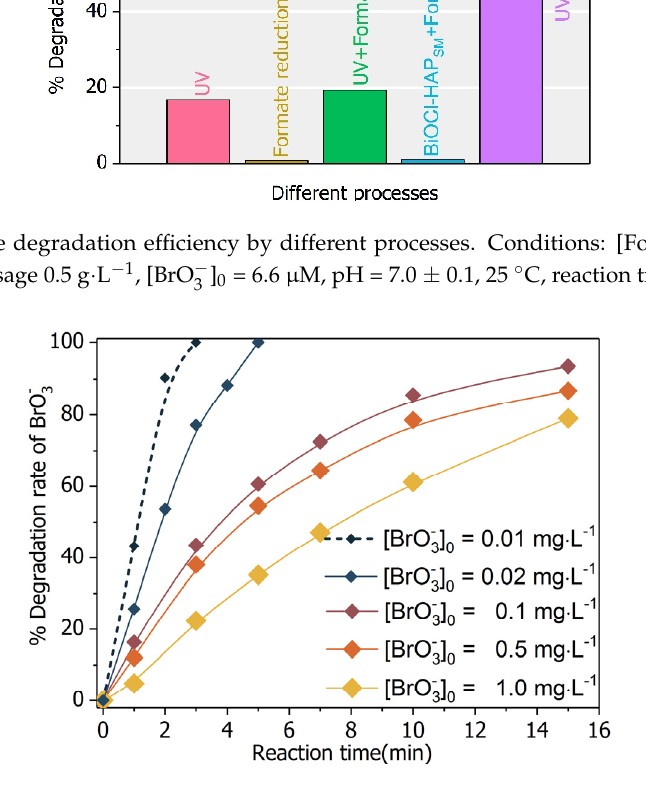
Figure 6. Bromate degradation by UV/BiOCl-HAP SM /formate: efficiency changes with variation of initial concentration of bromate ([ BrO (cid:2871)(cid:2879) ] 0 ). Conditions: [Formate] 0 = 4 mM, BiOCl-HAP SM dosage 0.5 g·L − 1 , pH = 7.0 ± 0.1, 25 °C.